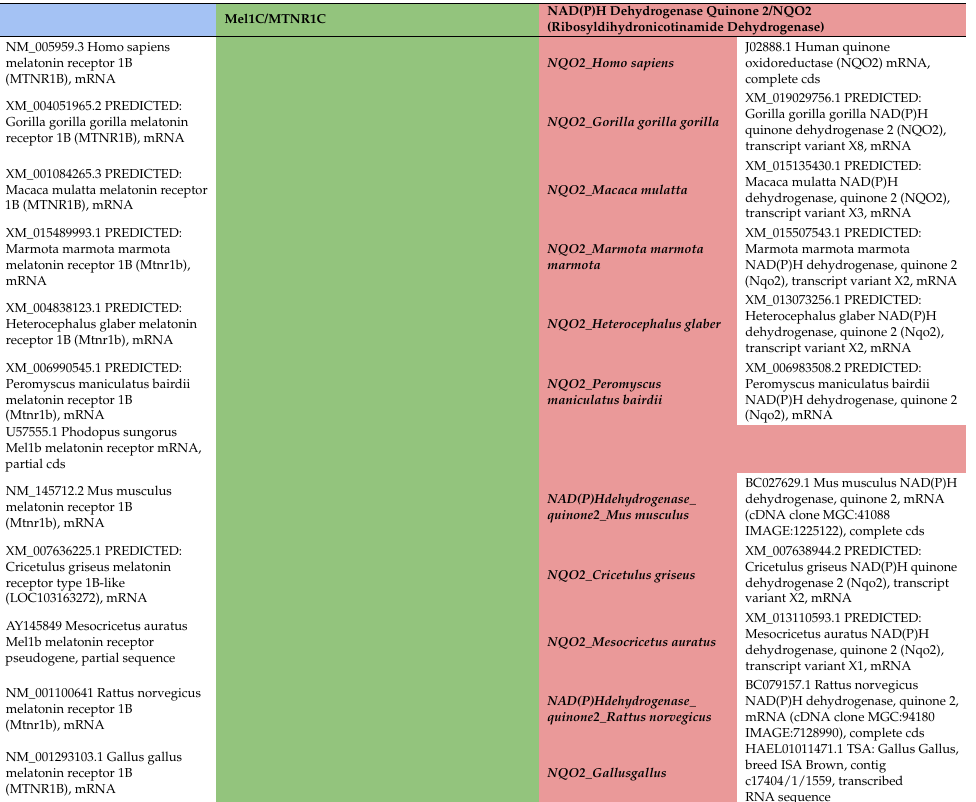
Table 1. NCBI accession numbers and full names of sequences used for phylogenetic analysis. All sequences that were available for the selected primates, rodents, and non-mammalian species were used. Species line up horizontally on this table. Mel1C has not been reported in mammals. NQO2/QR2 has been reported to be the putative MT3 receptor. Sequences were curated using Clustal Omega Multiple Sequence